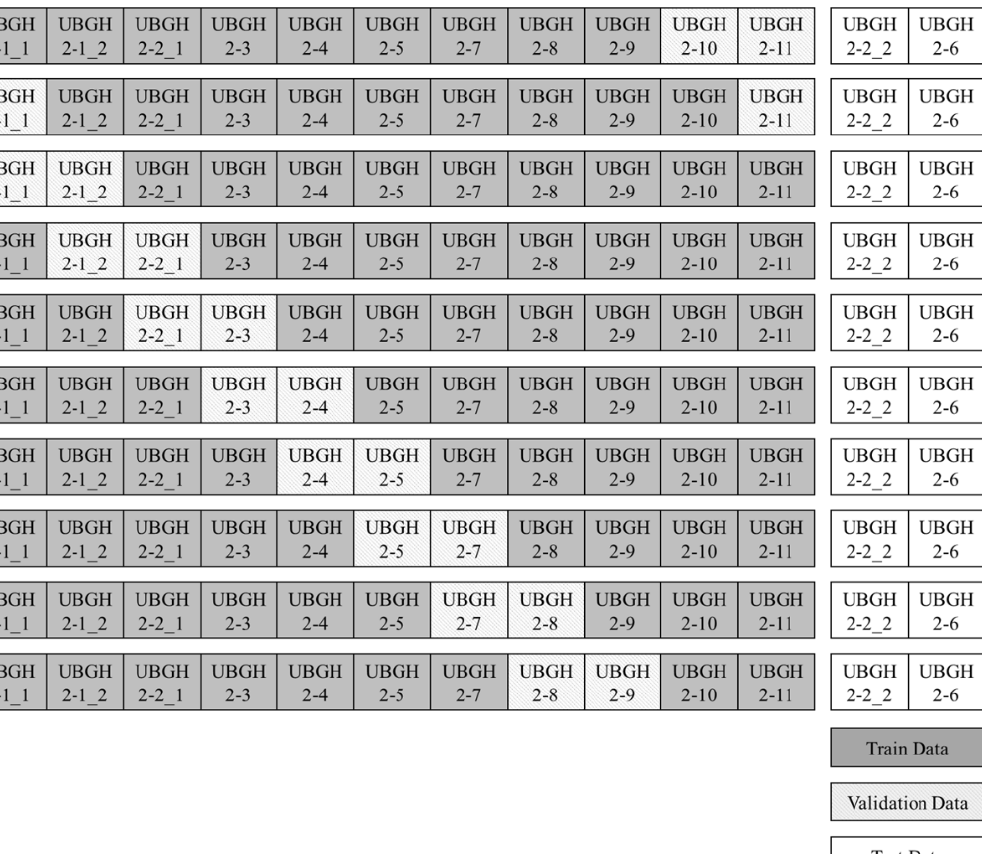
Figure 10. Training, validation, and test datasets in each fold of the 10-fold cross-validation for Vp prediction.